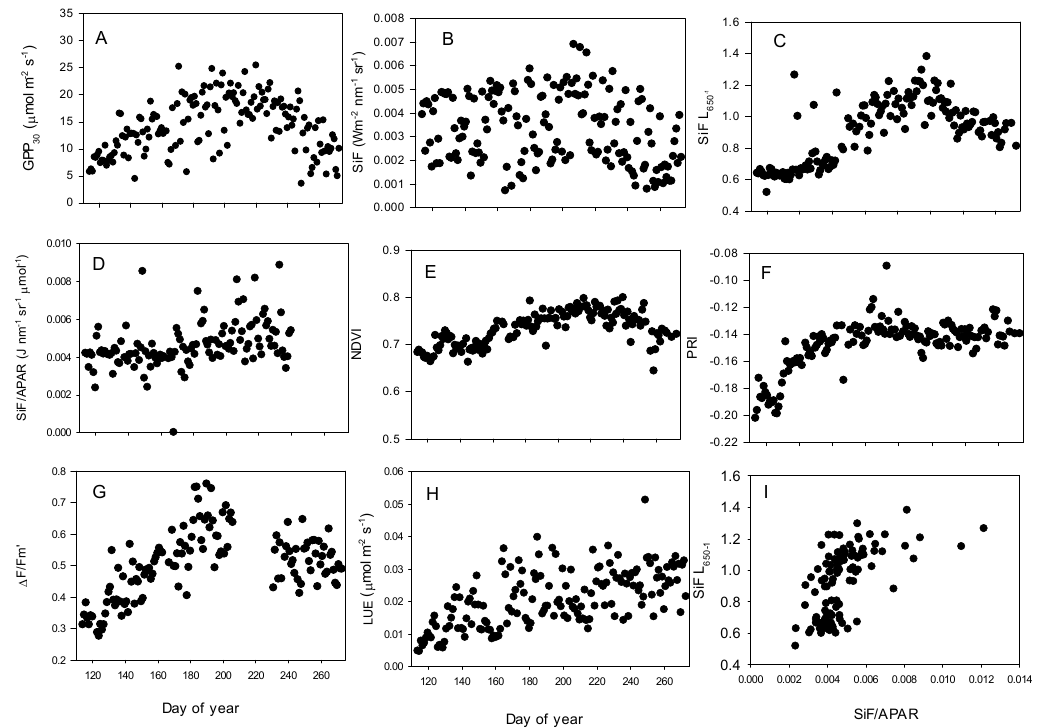
Figure 4. Seasonal patterns of a midday average (10–12 UTC) of: GPP 30 from flux tower data ( A ), SiF ( B ) and SiF L 650 − 1 ( C ) from canopy level measurements from the Ocean optics spectrometers, SIF/APAR ( D ), PRI, ( E ) NDVI ( F ) PRI, and ΔF/F m ’ ( G ) from the PAM system; LUE ( H ), ( I ) SiF L 650-1 to SiF/APAR. Rain and snow days were removed. Clear and cloudy observations are presented.